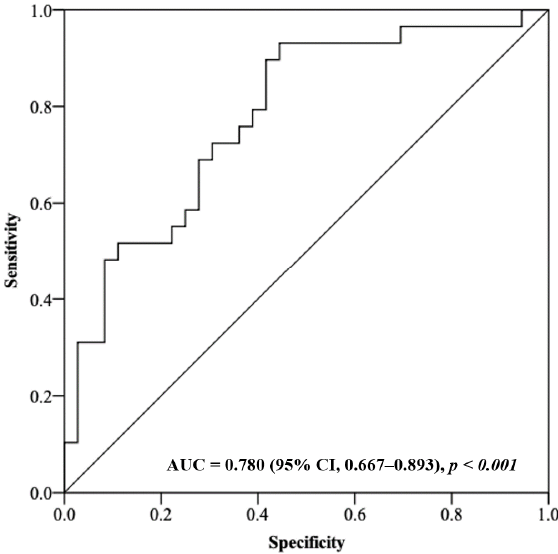
Figure 1. Receiver operating characteristic analysis using plasma GR activity as a predictor of the clinical outcome in septic shock patients.